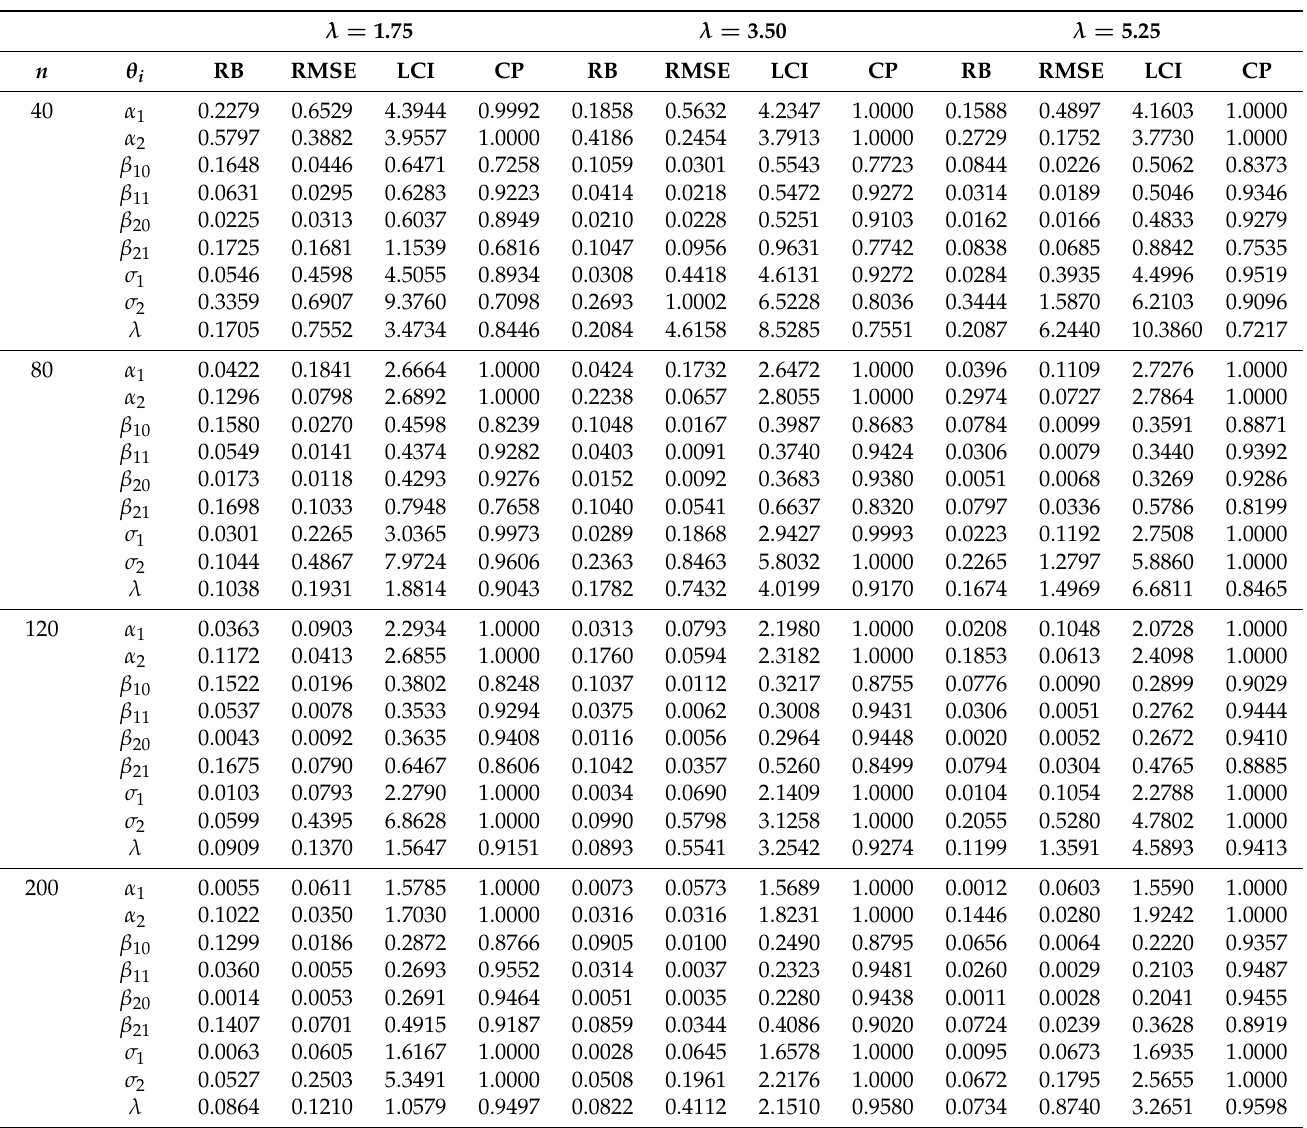
Table 2. Relative bias, root of mean square error, length of confidence interval, and coverage probability for the MVSUSHN regression